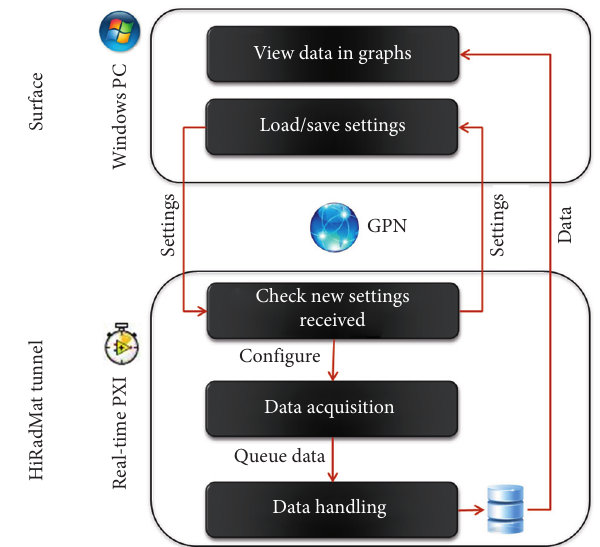
Figure 18: Communication